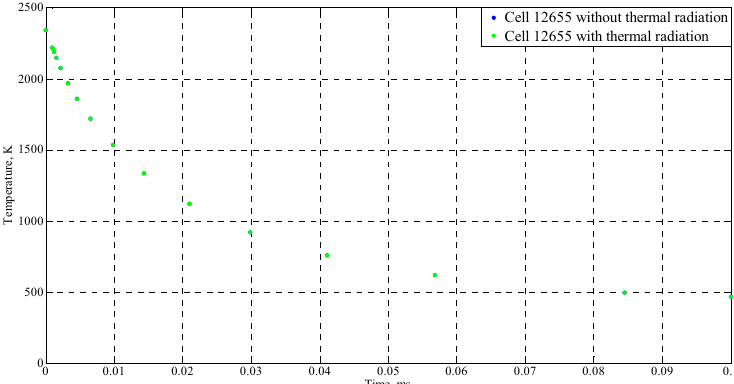
Figure 9. Temperature evolution in the splat cell 12655 with and without thermal radiation.